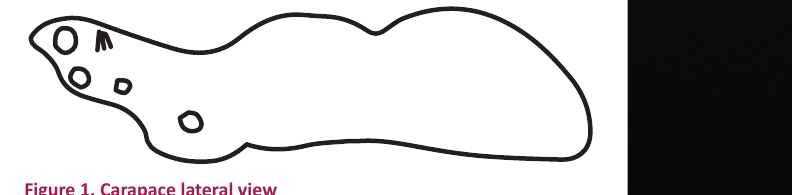
Figure 1. Carapace lateral